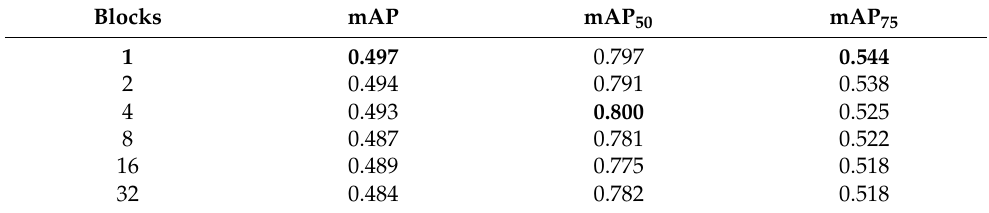
Table 3. Comparison of performance with varying number of Temporal Attention blocks.